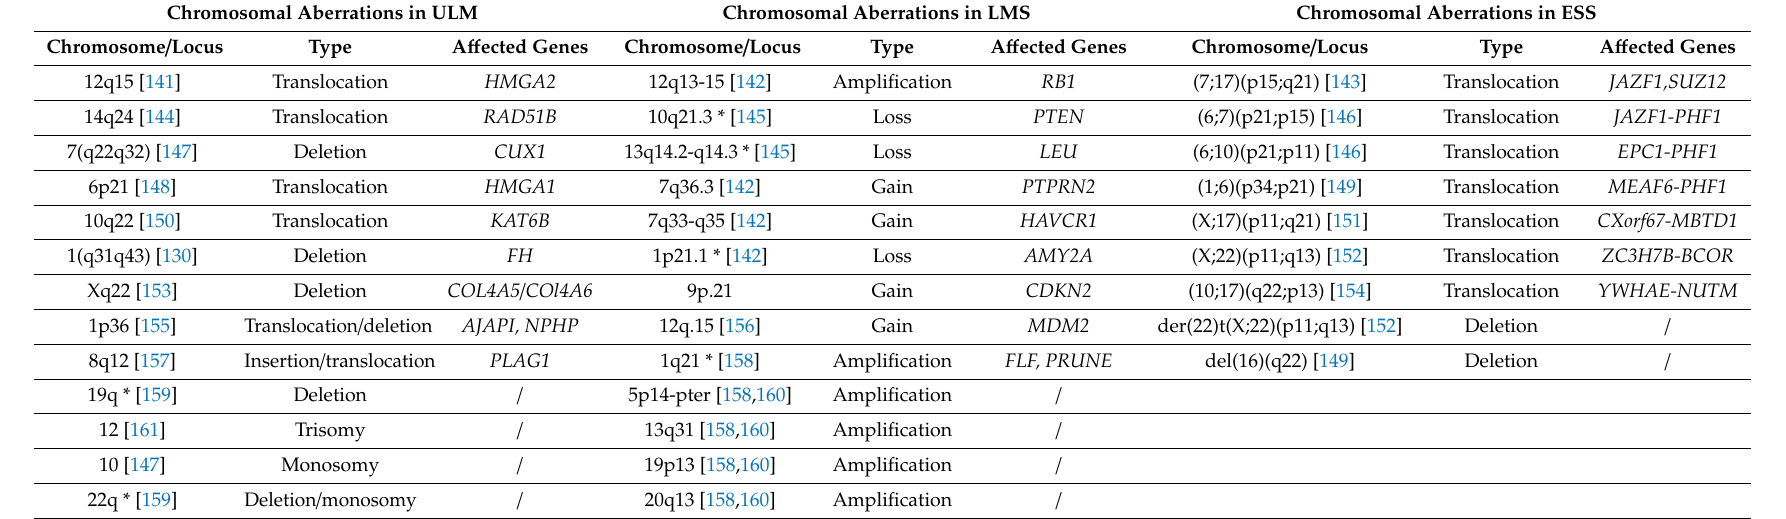
Table 2. Most typical chromosomal rearrangements in ULM, LMS, and